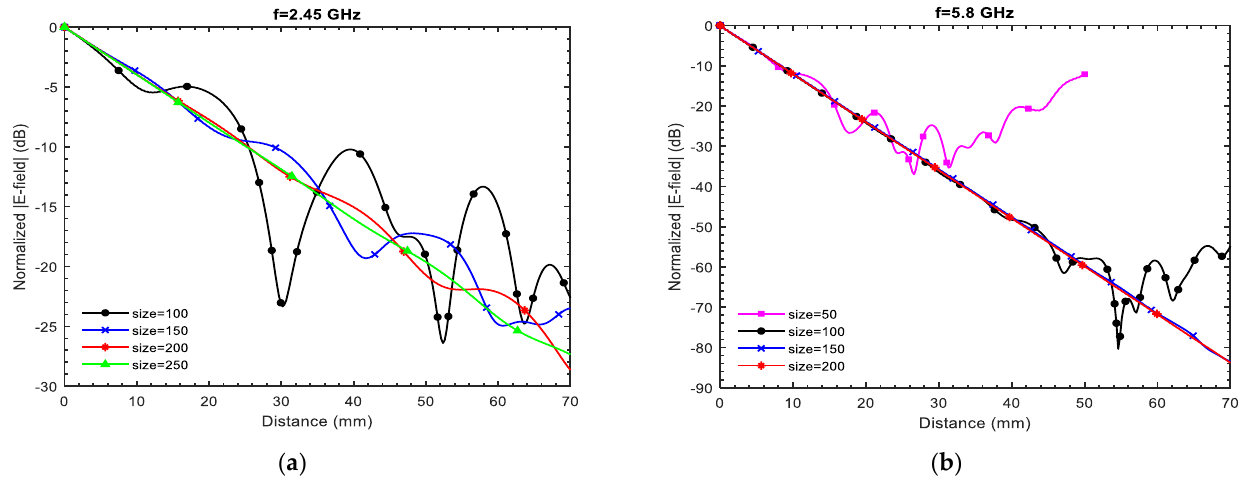
Figure 6. Normalized electric field vs. insertion distance (z axis) computation using CST for a phantom dimension of (size mm × size mm × size mm. ( a ) f = 2.45 GHz and ( b ) f = 5.8 GHz. Table 1. Minimum phantom size that reliably represents an entire body for implant communication at a 10 mm to 50 mm insertion depth and corresponding absorption